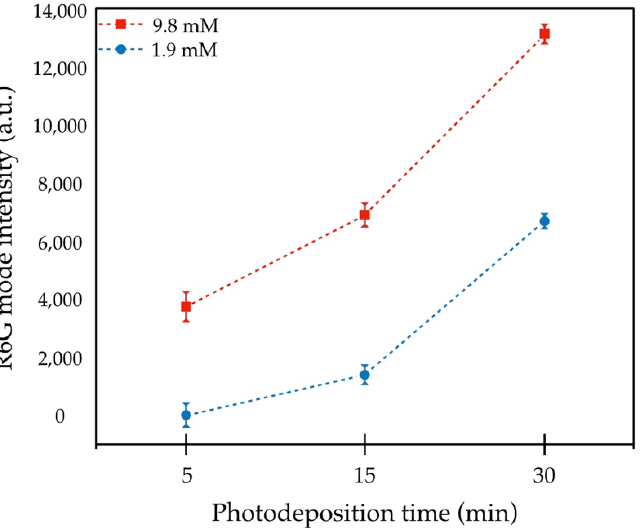
Figure 11. Raman intensity of R6G mode at 1508 cm − 1 as function of photodeposition time at 1.9 and 9.8 mM of AgNO 3 .